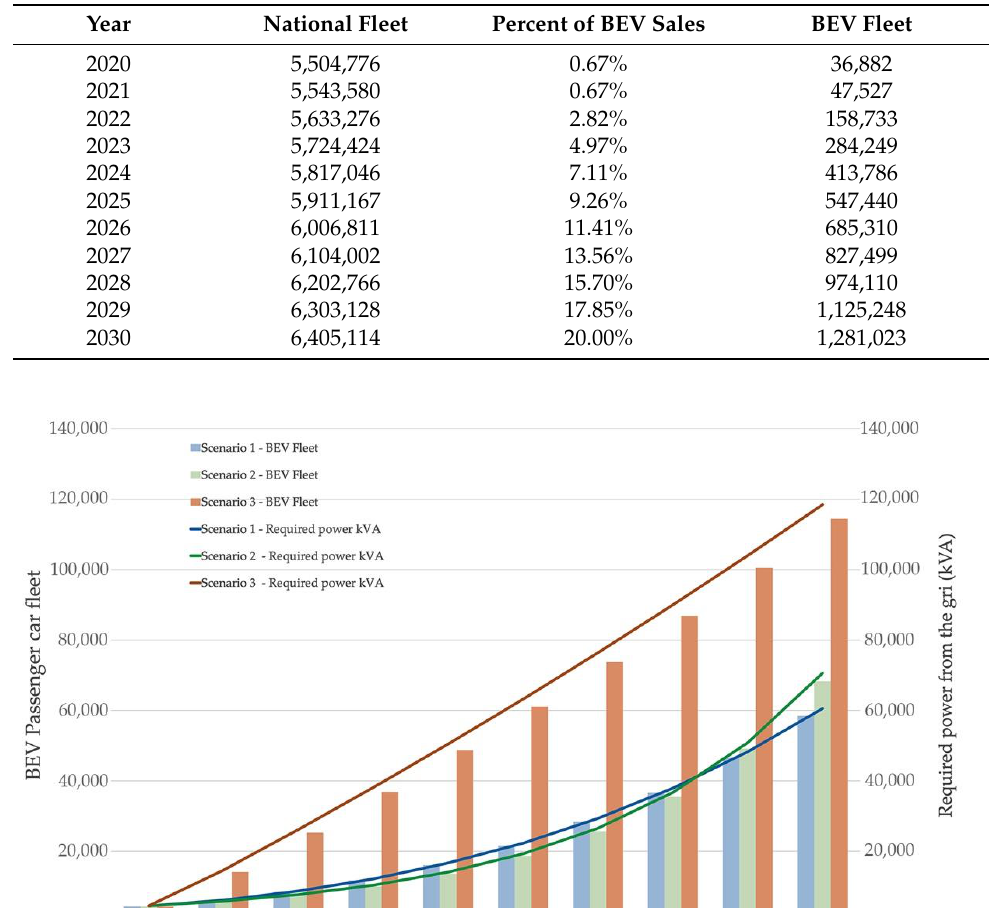
Table 7. Calculation of the BEV fleet in scenario